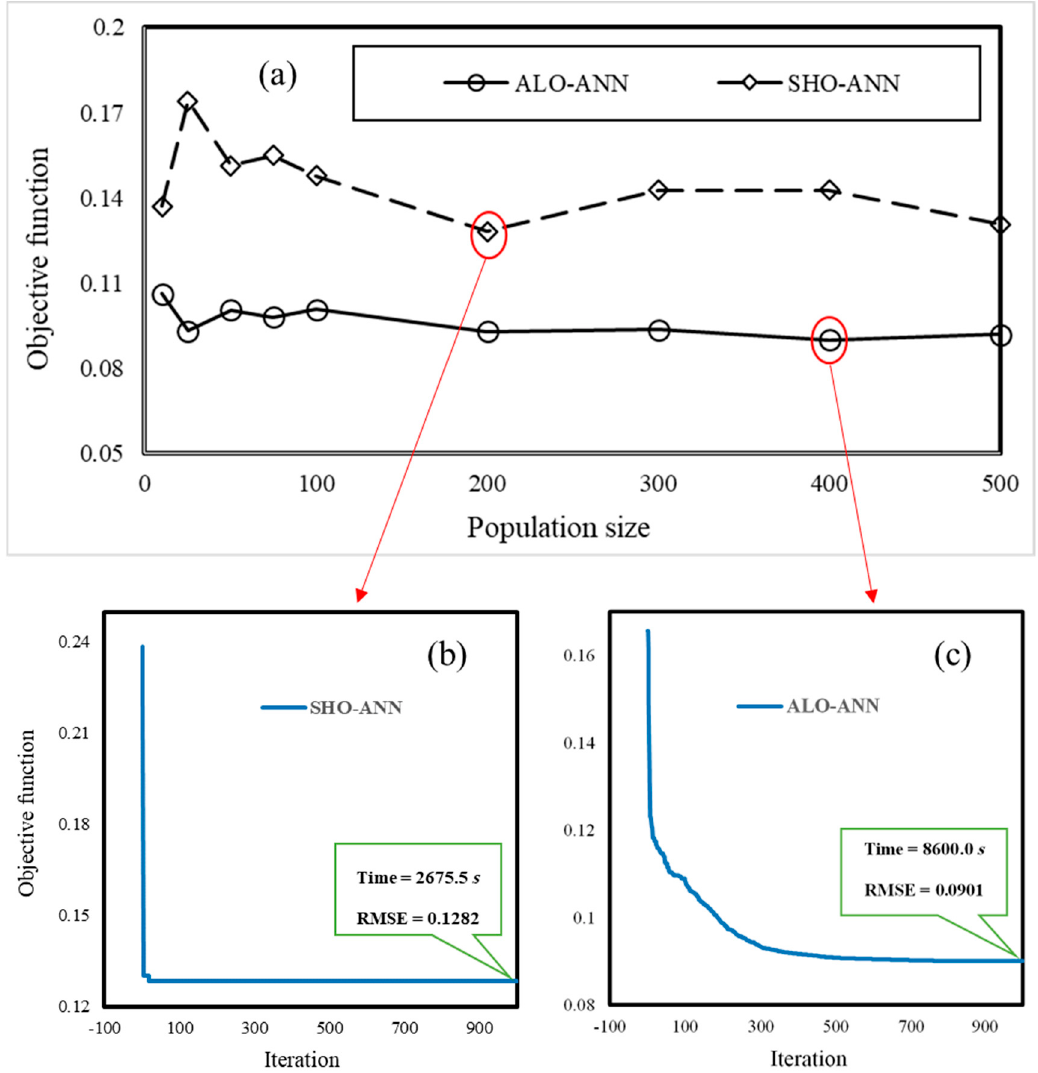
Figure 5. ( a ) The results of the executed trial and error process, ( b , c ) the convergence curve of the elite SHO–ANN and ALO–ANN, respectively. ANN, artificial neural network; ALO, ant lion